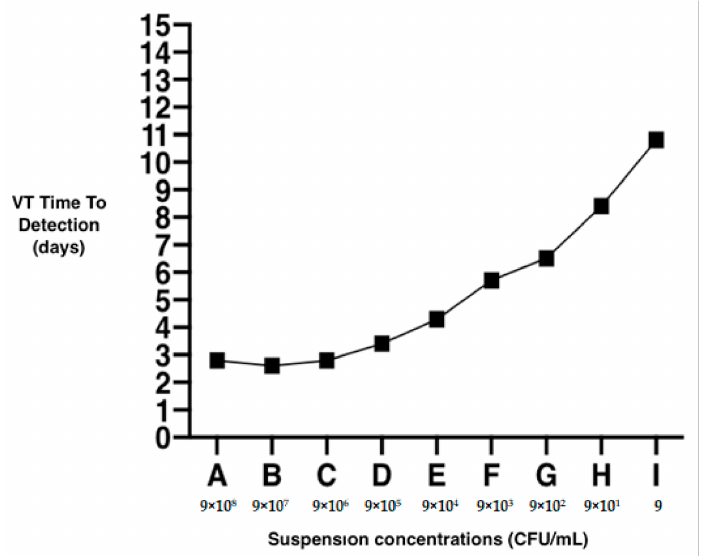
Figure 2. Time rate of exponential growth (one log) for concentrations (A–I) after incubation in the VersaTREK™ system and using mMVT broth.